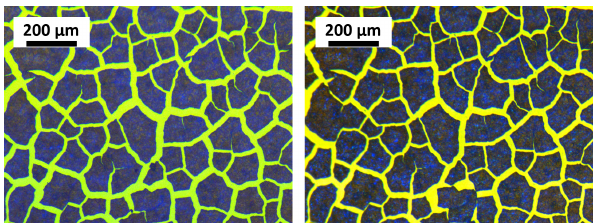
Figure 2. Optical microscope images from an as-synthesized in- dium oxide film (left) and after annealing at 550 ◦ C for 77h (double heated for 5 + 72h, see text) (right) at the same location of the same